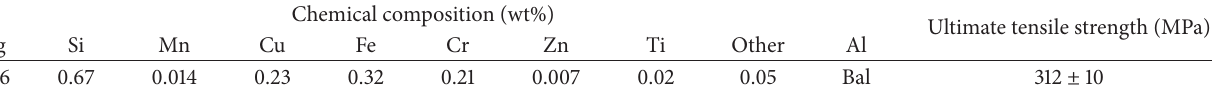
Table 1: Chemical composition of alloy elements in the 6061-T6 plates.